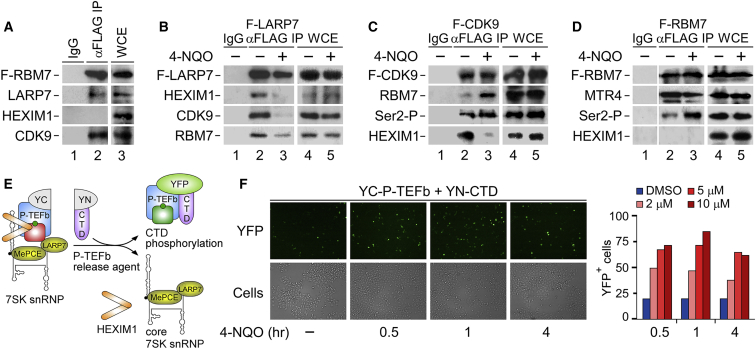
Genotoxic Stress Induces the Relocation of P-TEFb and RBM7 from 7SK snRNP to Pol II(A and B) CoIP of F-RBM7 (A) and F-LARP7 (B) with 7SK snRNP from WCE of HEK293 cells. Conditions with (+) and without (−) 4-NQO are shown.(C and D) CoIP of F-CDK9 (C) and F-RBM7 (D) with the indicated proteins from WCE of HEK293 cells. Conditions with (+) and without (−) 4-NQO are shown.(E) Cartoon depicting the V-PAC assay. P-TEFb-releasing agents induce the transfer of the inactive YC-P-TEFb (inactive CDK9 in red) to the substrate YN-CTD chimera (active CDK9 in green), yielding YFP fluorescence.(F) V-PAC assay in HeLa cells expressing YC-P-TEFb and YN-CTD chimera. Left: representative YFP fluorescence (YFP) and phase contrast (cells) images of cells are shown. Conditions with (in hours) and without (−) 4-NQO are shown. Right: quantification of YFP-positive cells that were treated as indicated.See also Figure S2.